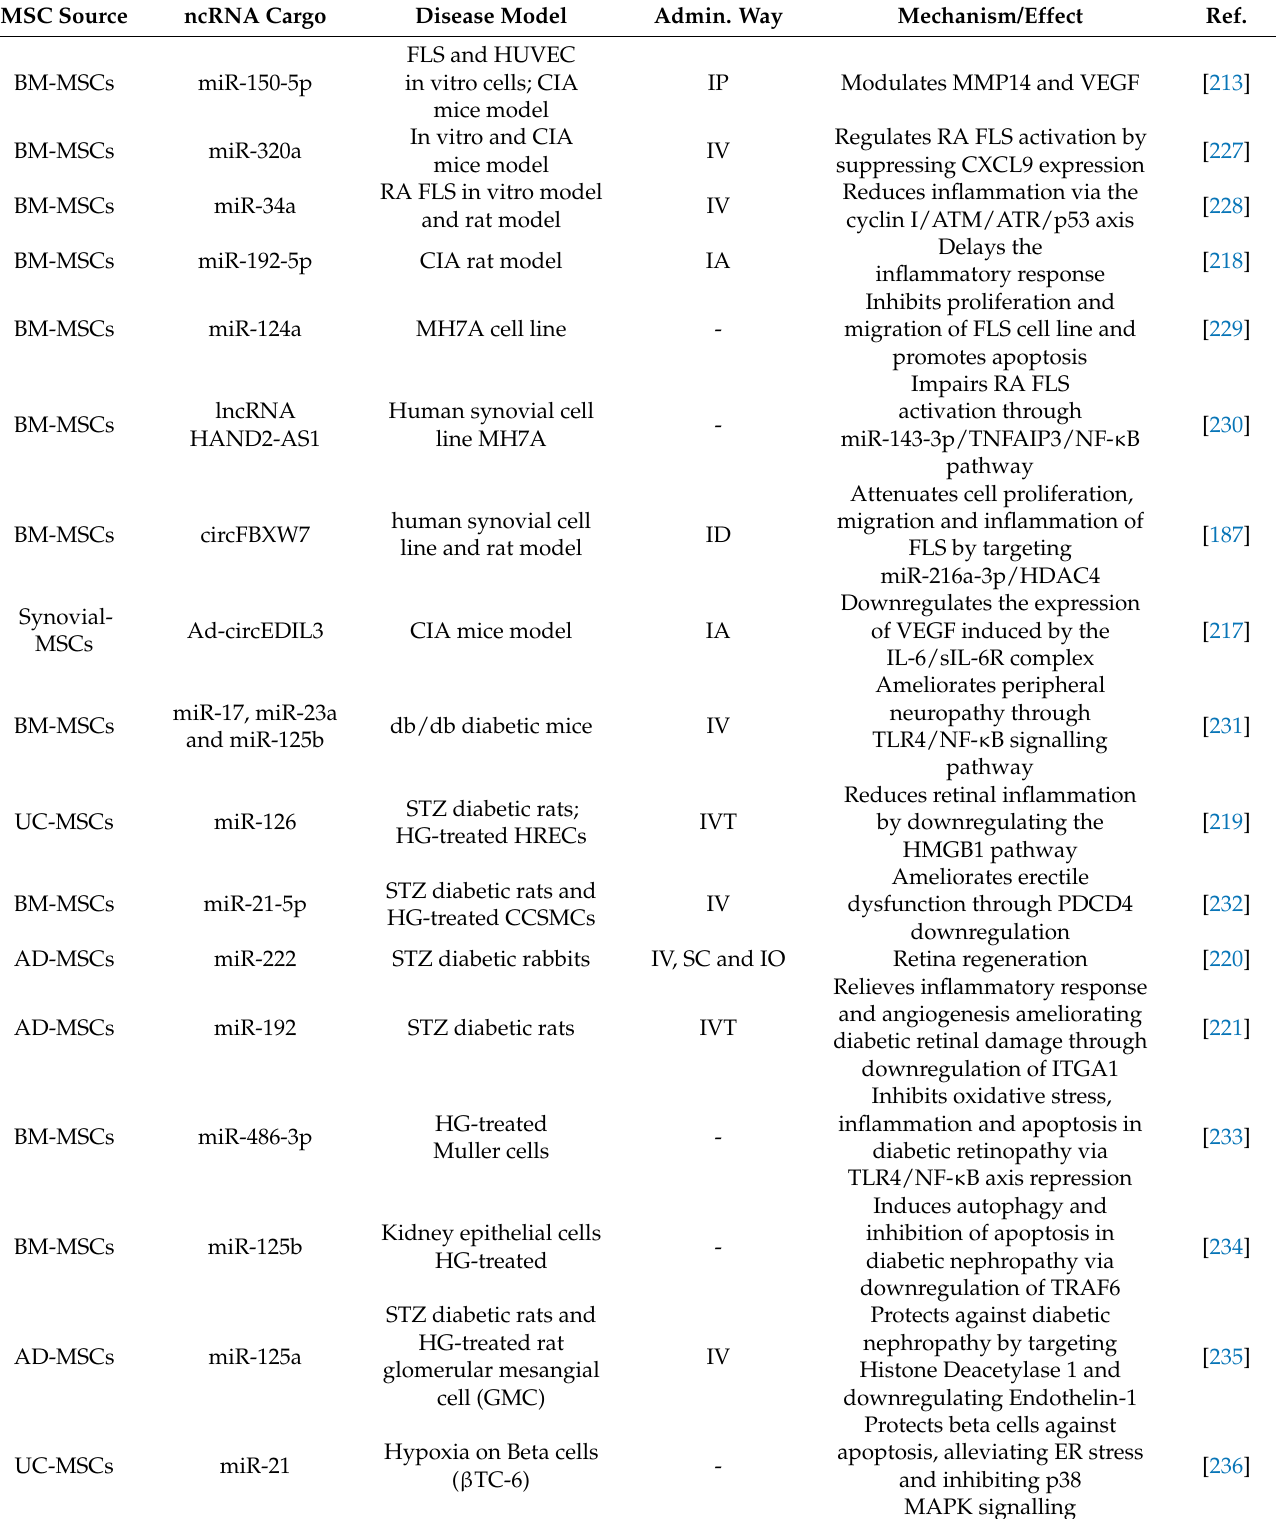
Table 1. Preclinical studies based on MSC-EV therapy in autoimmune